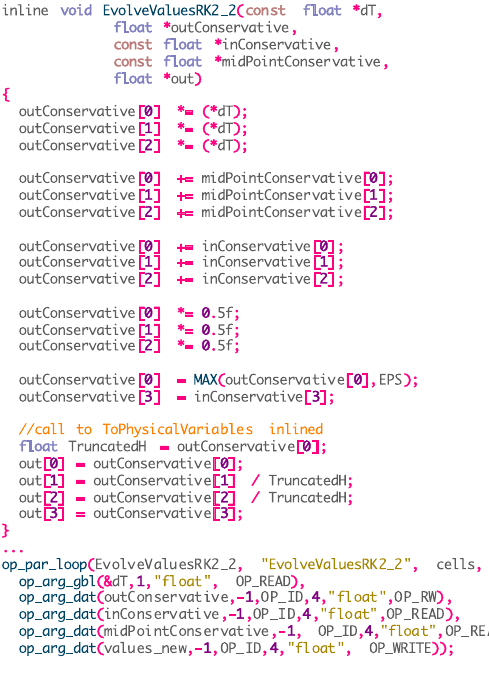
Figure 5. Code snippets from the original and OP2